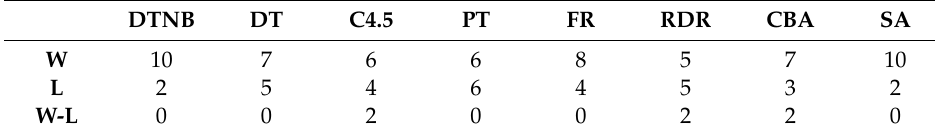
Table 9. Statistically significant wins / losses counts of J&B method on rules.